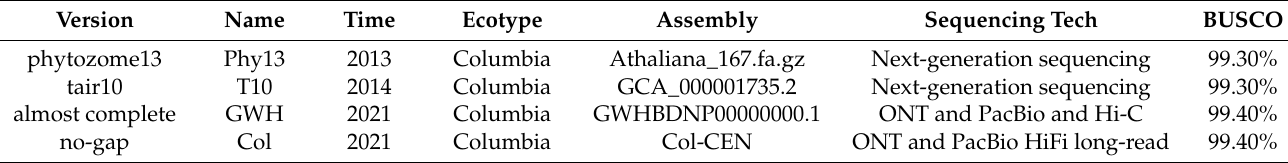
Table 1. Basic information on A. thaliana genomic data.